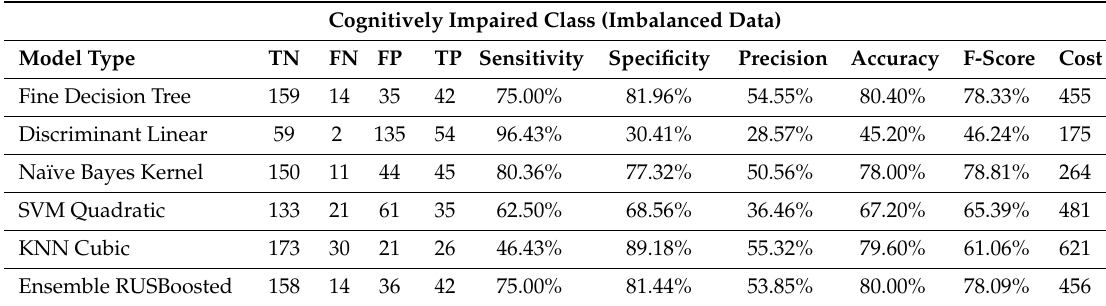
Table 3. Train the model with a bias to reduce FN and increase TP